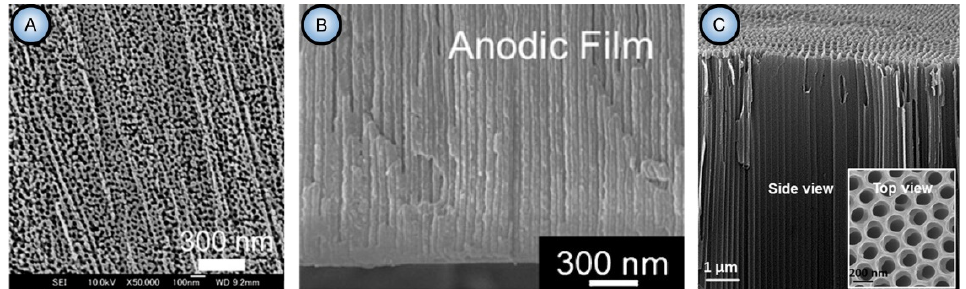
Figure 3. SEM micrographs of the top surfaces and the cross-sections of porous layers obtained by anodic oxidation of different “valve metals”, such as iron ( A , B ) and titanium ( C ). Fe was anodized in ethylene glycol solution containing 0.1 mol L − 1 NH 4 F and 0.5 mol L − 1 H 2 O at 50 A m − 2 and 20 °C (Konno et al., [18]); Ti was anodized in ethylene glycol containing 0.3 wt % NH 4 F and 2 vol % H 2 O at 50 V (Xue et al., [19]). Reproduced with permissions. Copyrights 2012 Springer, American Chemical Society.